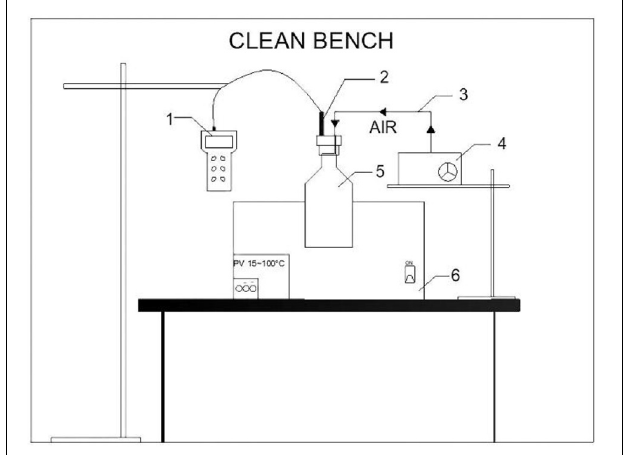
FIGURE 1 | Experimental setup for measuring saturated dissolved oxygen concentration in bioleaching solutions (1—dissolved oxygen